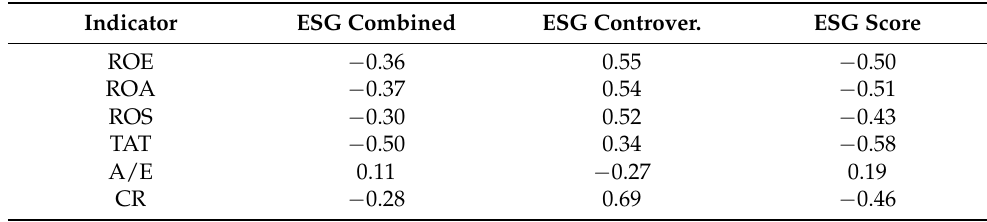
Table 9. Correlations between values of indicators taken into account in research in the case of the enterprise Energa S.A. (period of 2014–2019).